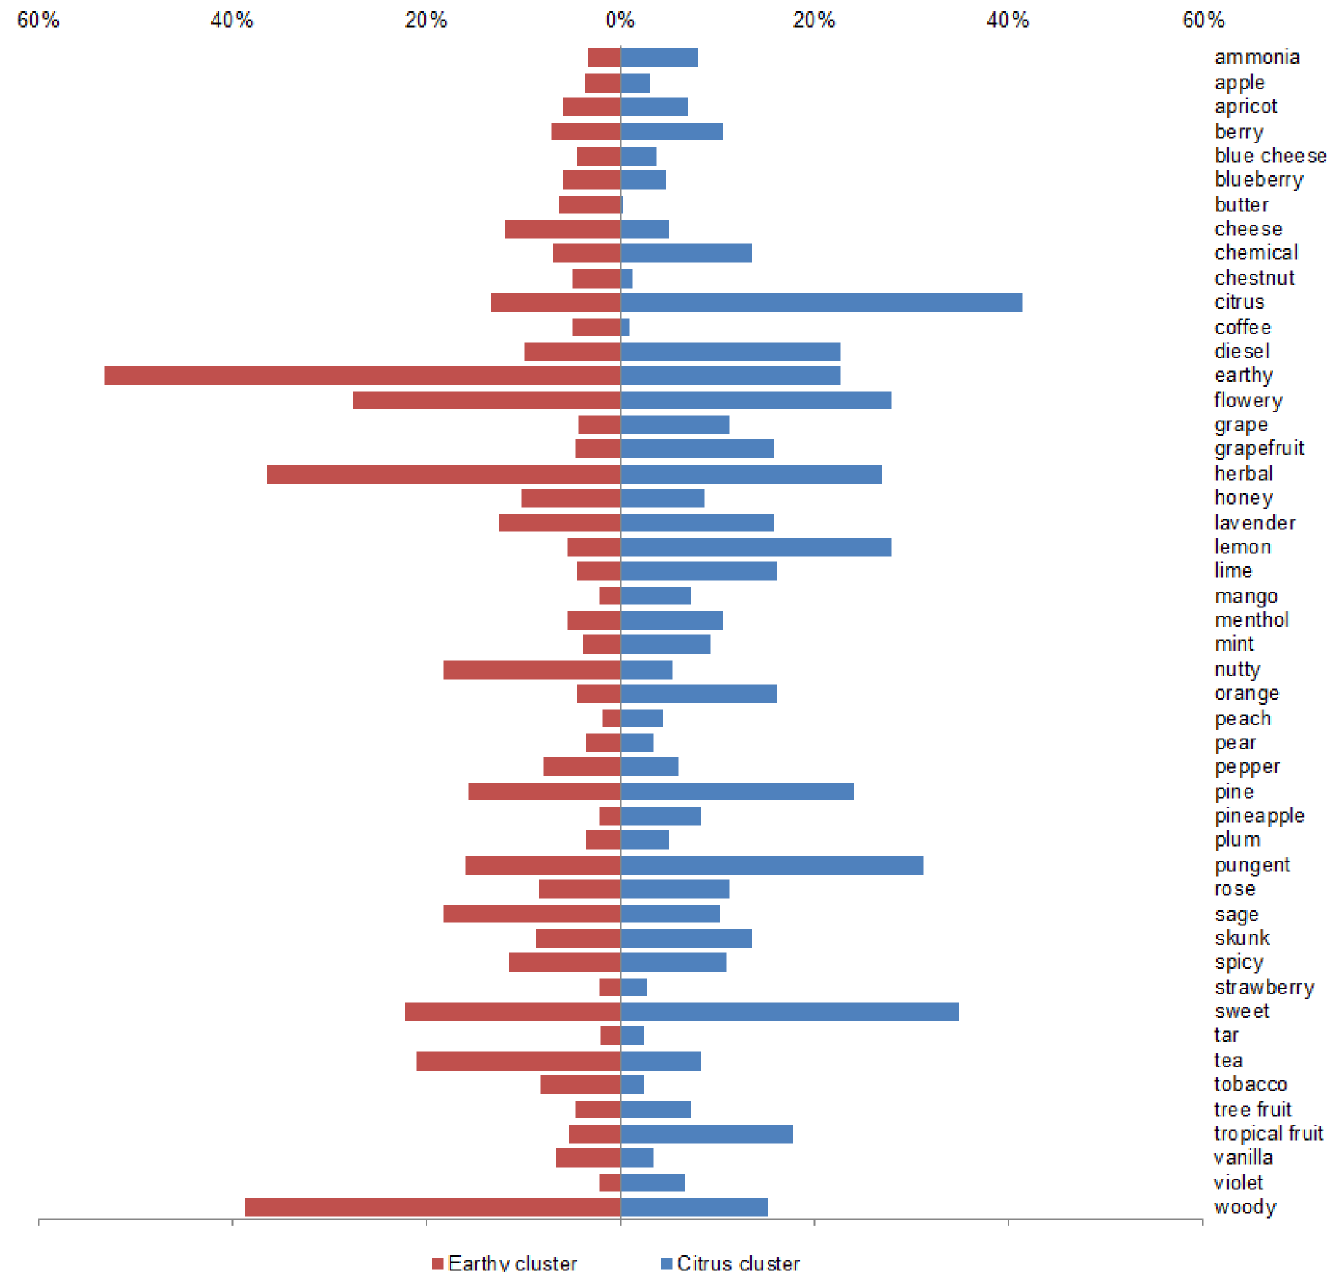
Fig 5. Composite aroma profiles for samples in Cluster A (Earthy) and Cluster B (Citrus). Percentages refer proportion of observations in which the odor descriptor was endorsed. There were 5 samples in the Citrus cluster and 8 samples in the Earthy cluster.